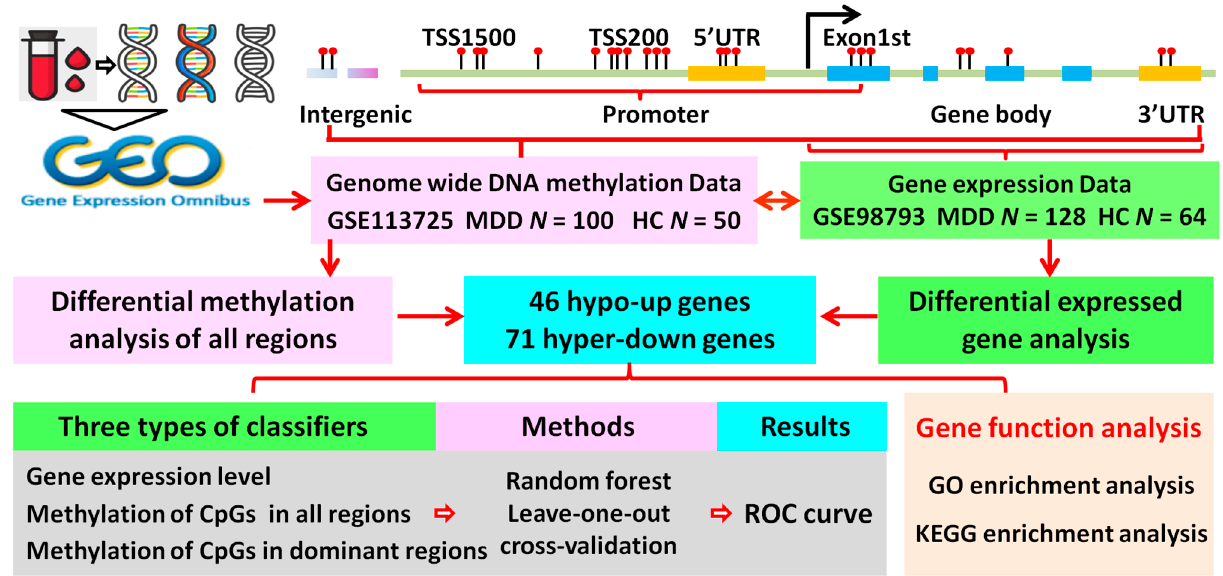
Figure 1. Flowchart of the analysis process. CpGs, 5 ′ -C-phosphate-G-3 ′ ; GO, Gene Ontology; HC, healthy control; hyper-down, hyper-methylated and down-regulated; hypo-up, hypo-methylated and up-regulated; KEGG, Kyoto Encyclopedia of Genes and Genomes; MDD, major depressive disorder; ROC, receiver operating characteristic; TSS, transcriptional start site; UTR, untranslated region. N , number of MDD or HC.